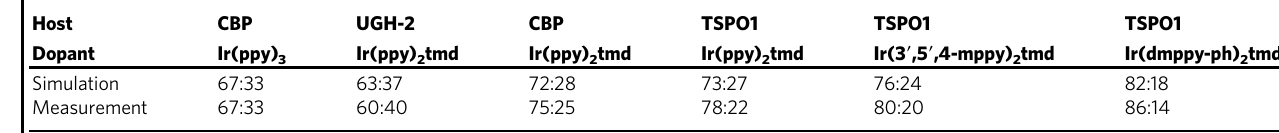
Fig. 4. The C 2 axis is toward the ancillary ligand ( dark blue arrows ) and the TDM vector ( red arrows ) is approximately along the direction from the iridium center to one of the pyridine rings. The alignment of iridium-pyridines determines the orientations of TDM for Ir(ppy) 2 tmd, Ir(3 ′ ,5 ′ ,4-mppy) 2 tmd, and Ir(dmppy-ph) 2 tmd. Figure 4 shows fi ve con fi gurations with dif- ferent rotation angles of the C 2 axis for the horizontal TDM and one con fi guration for the vertical TDM. Rotation of the C 2 axis from the vertical to the horizontal direction can result in the plane (substrate) with an arbitrary orientation of the ancillary ligand. In other words, horizontal EDO is possible no matter